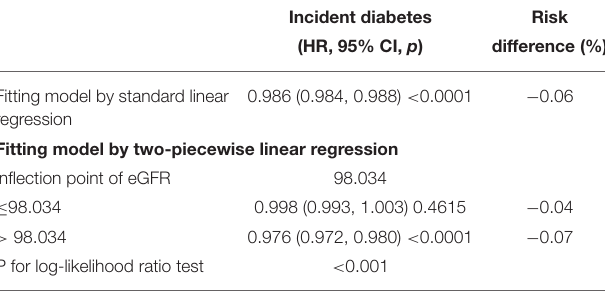
TABLE 5 | The result of the two-piecewise linear regression model.